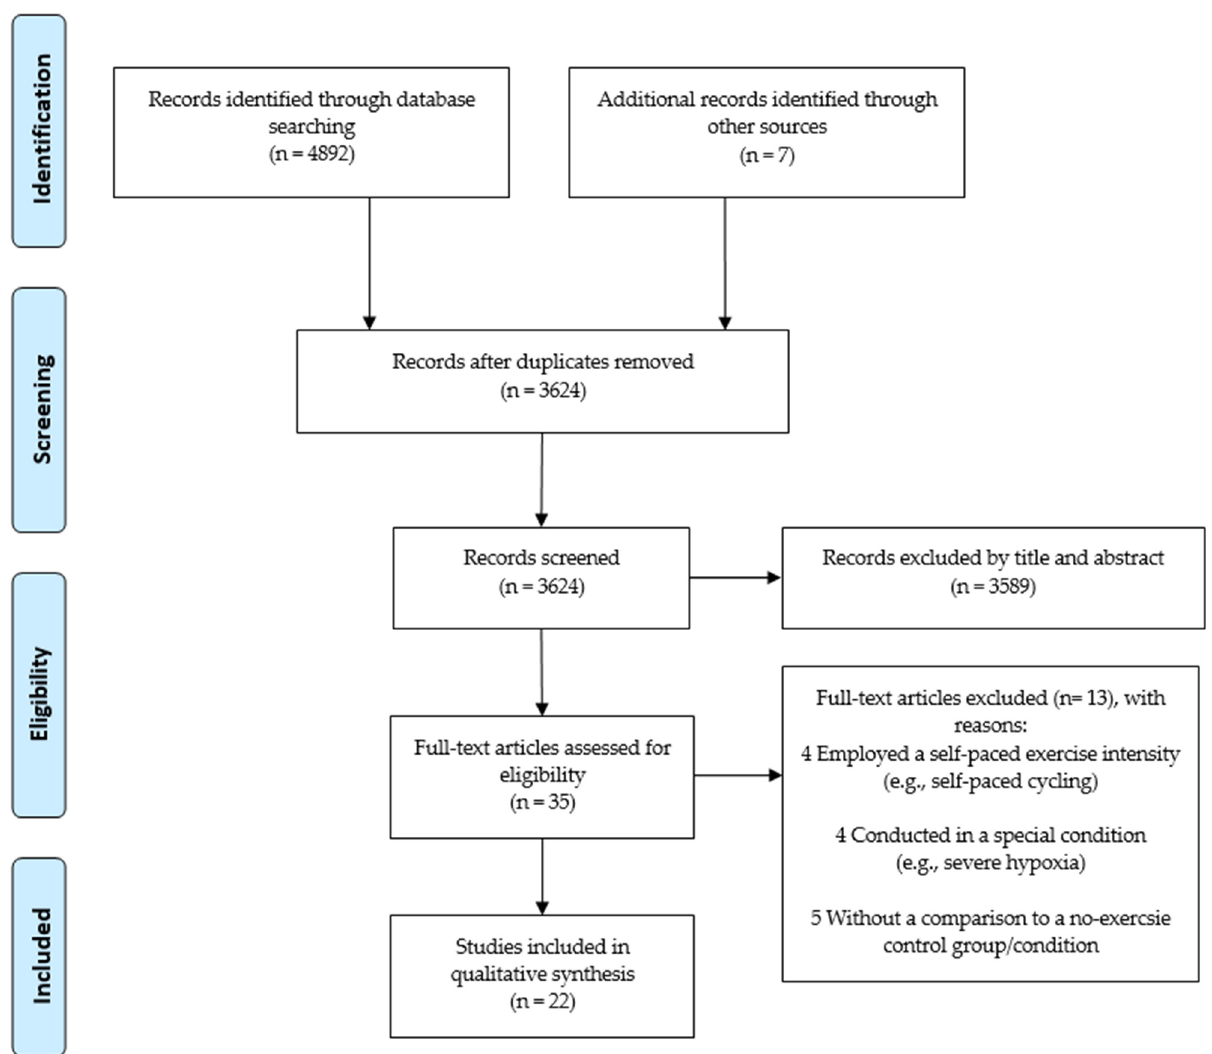
Figure 1. Flow chart of study selection. Table 1. Characteristics of the included studies.